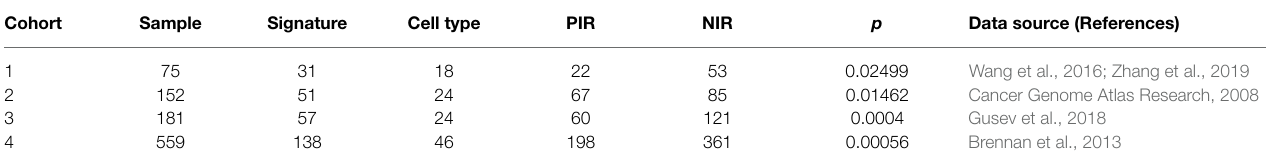
TABLE 1 | Hierarchical clustering results for the four